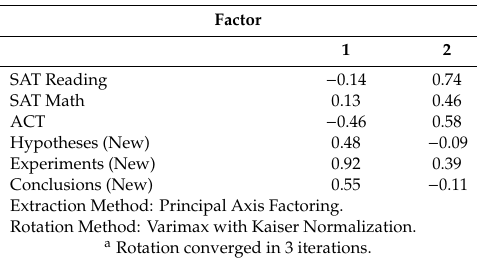
Table 6. Study 1 Principal Axis Factor Analyses: New Measures Plus College-Admissions Tests ( g- based). Rotated Principal-Factor Matrix a